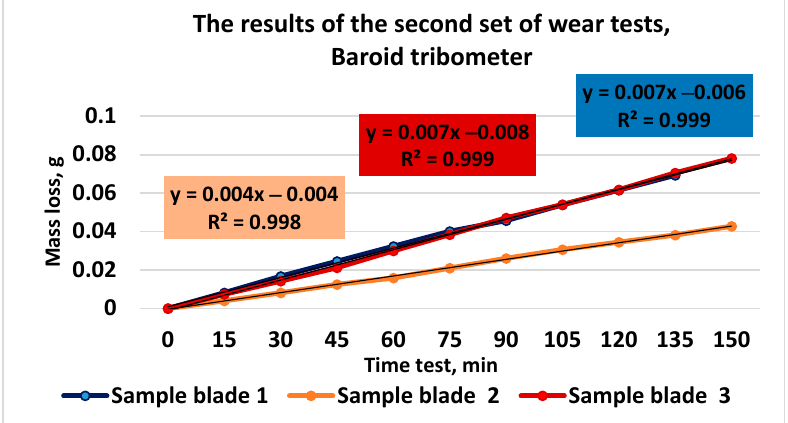
Figure 10. The results of the second set of wear tests.